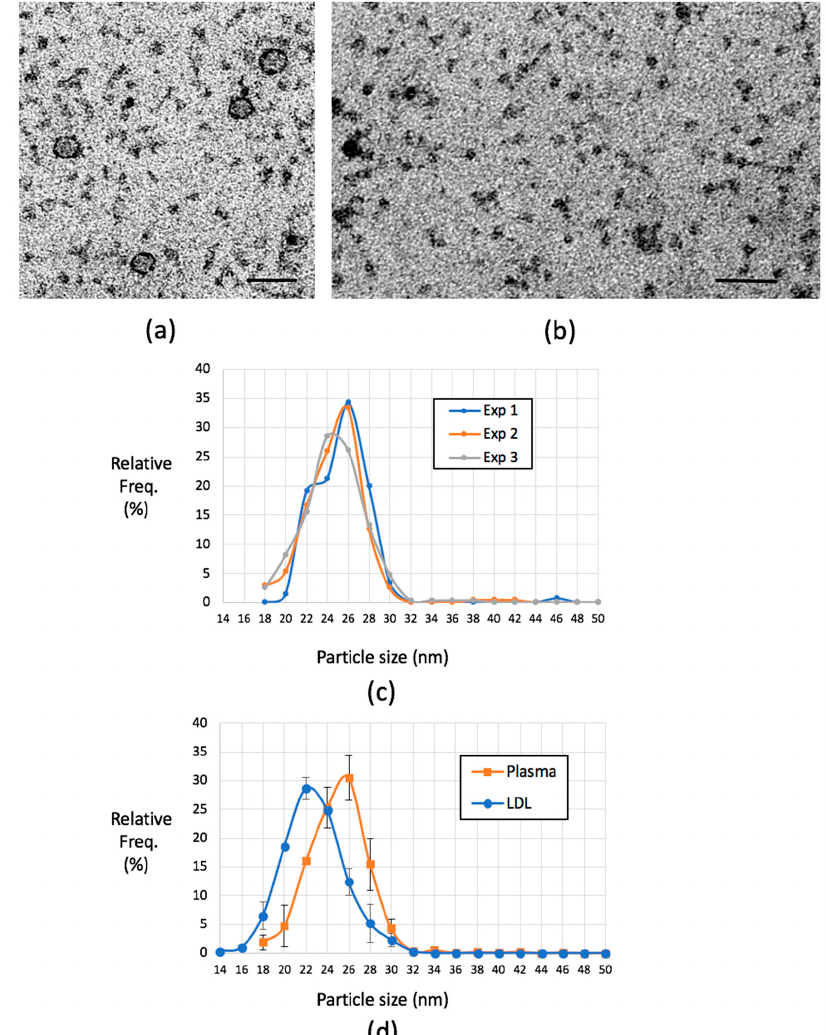
Figure 6. Visualisation of LPs in diluted human plasma. ( a ) Human plasma diluted 1 in 4000 in phosphate buffered saline (PBS). Clear lipoprotein particles with strong edge contrast are interspersed with putative plasma proteins also seen in ( b ). ( c ) Three samples of human plasma processed and quantified (> 100 particles examined in each case). Distributions were not significantly different; Kruskal–Wallis test statistic H = 0.326, p = 0.8494. ( d ) Distribution of mean LP sizes compared to purified LDL data (error bars SDs). Scale bars in ( a ) and ( b ), 50 nm. In ( c ) and ( d ) data are expressed as the relative frequency of particle number for each particle size category expressed as a percentage of total particles analyzed (Relative Freq. %).